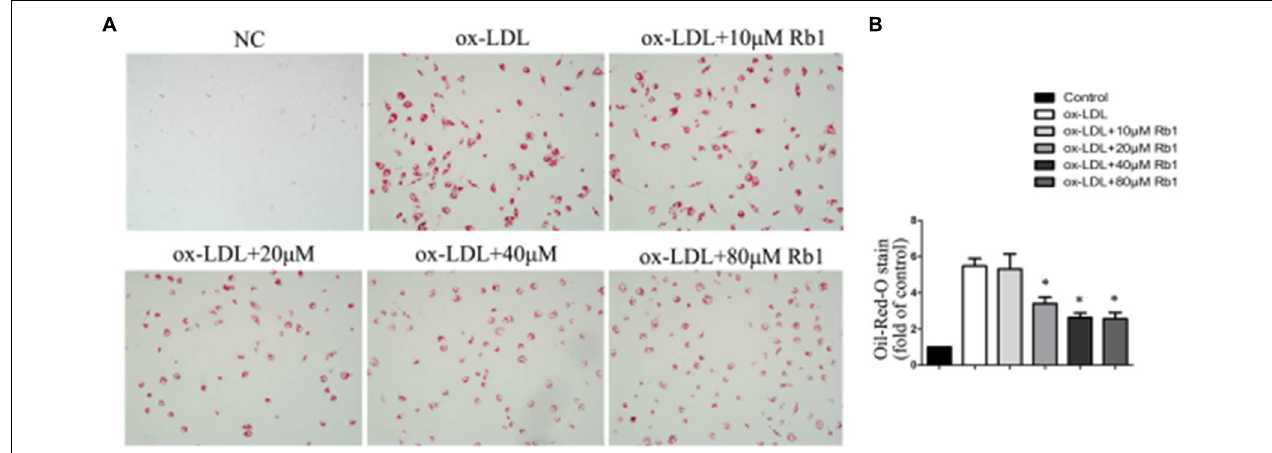
FIGURE 1 | Rb1 decreased lipid accumulation in macrophage foam cells. Primary peritoneal macrophages from C57BL/6 mice were incubated with ox-LDL (100 µ g/ml) for 24 h and further incubated in the absence or presence of different doses of Rb1 for another 24 h. (A,B) oil red O staining was performed to assess lipid accumulation in macrophages. ∗ p < 0.05, compared to the ox-LDL group, n = 3.